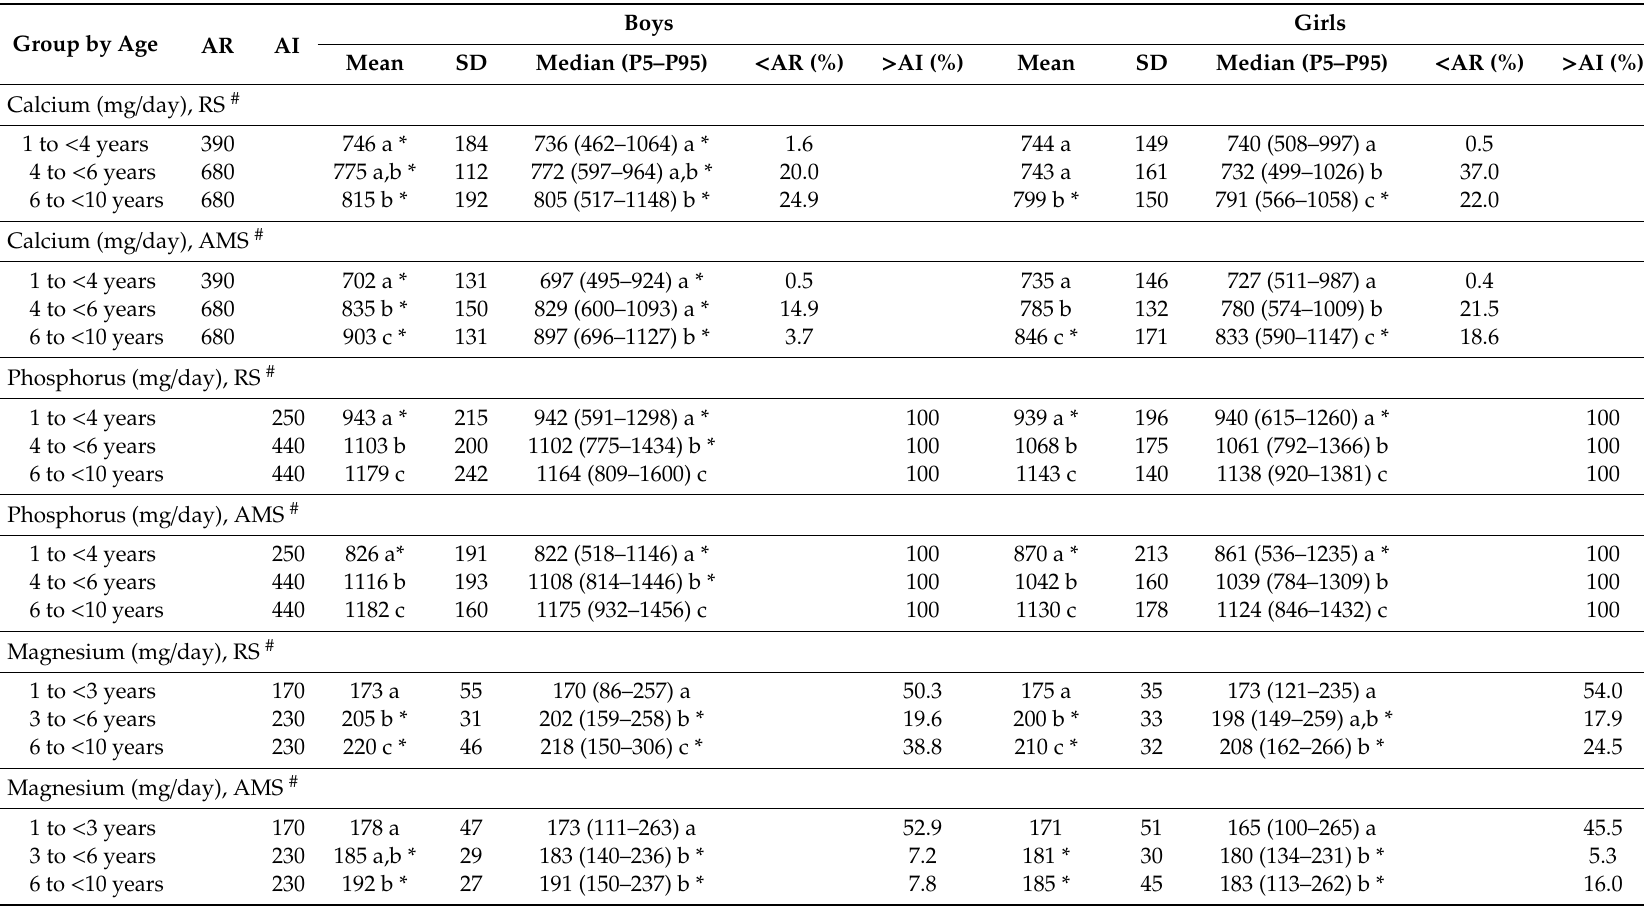
Table 2. Daily calcium, phosphorus, magnesium, and vitamin D usual intake by sex and age group in the EsNuPI population. Di ff erences between RS and AMS groups (n =